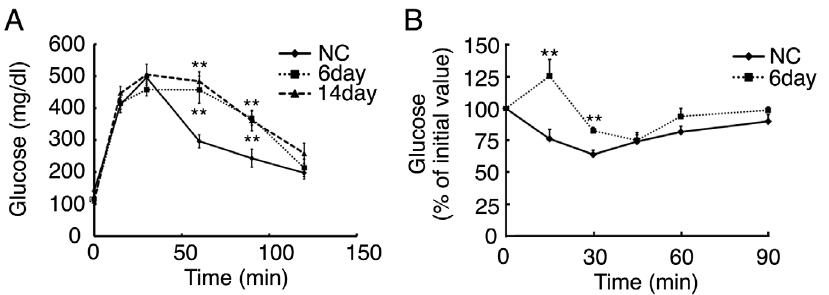
Figure 2. Glucose tolerance and insulin tolerance tests of mice fed KD. (A) A glucose tolerance test (GTT) of 3-month-old mice fed KD for 6 days or 14 days, or NC (n=8–11 per group; **, P , 0.01 vs. mice fed NC at the same timepoint). (B) An insulin tolerance test of mice fed KD for